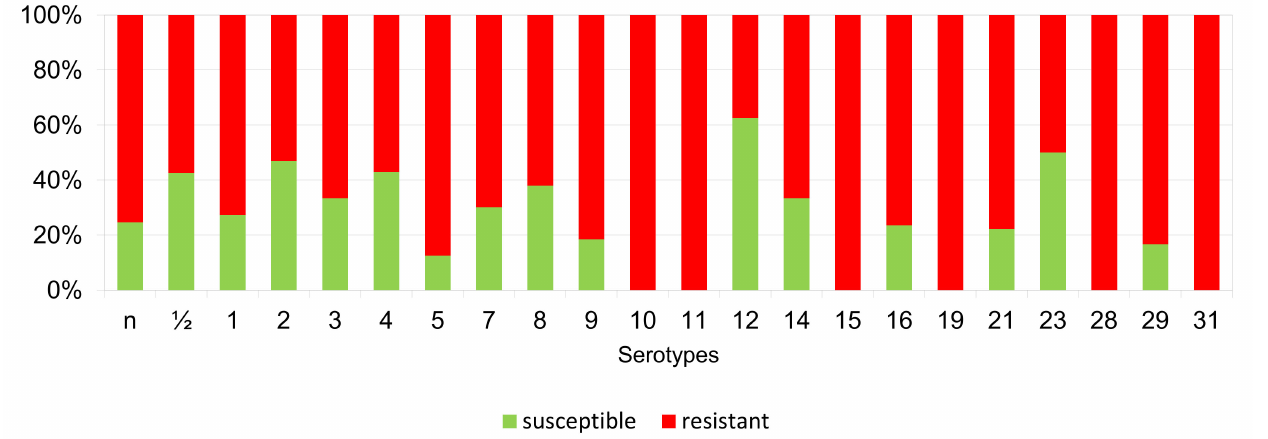
Figure 11. Percentage representation of isolates resistant, intermediately resistant, and susceptible to tilmicosin belonging to individual S. suis serotypes from the Czech Republic during 2018–2022. ( n = 506). n = non-typeable